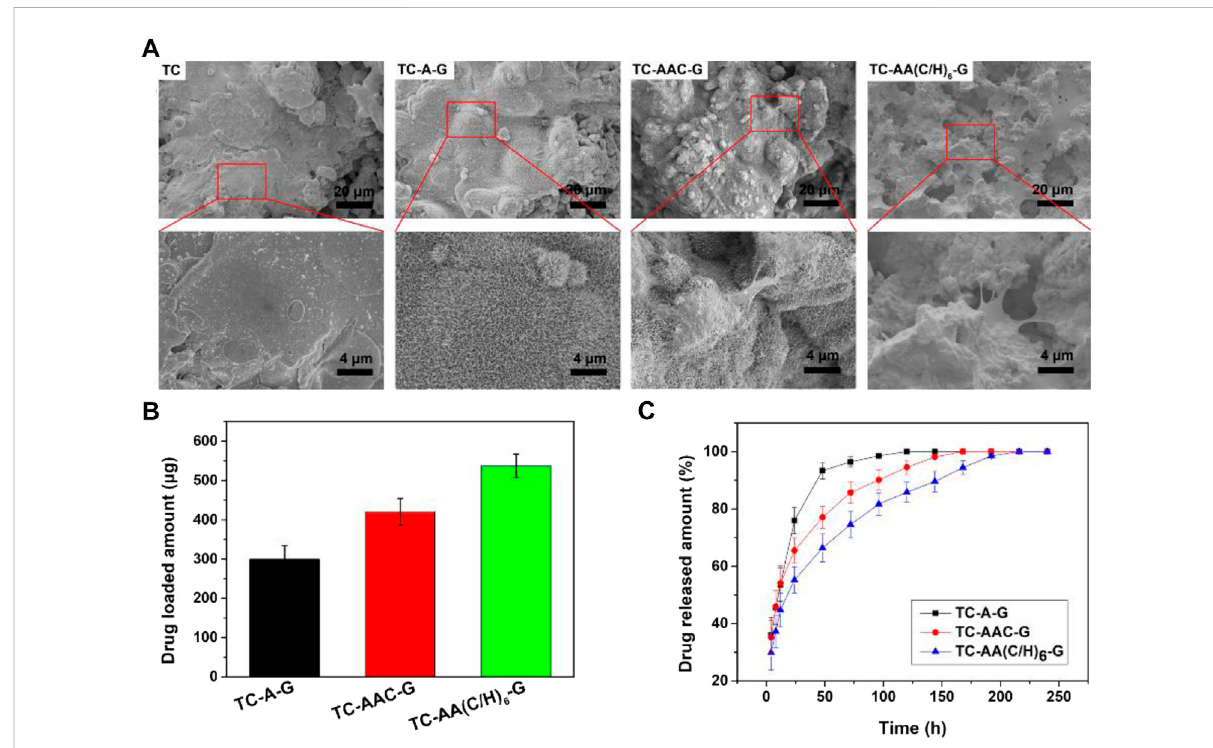
FIGURE 2 SEM of samples (A) , Drug loaded amount (B) and cumulative release curves of gentamicin (C) of TC-A-G, TC-AAC-G and TC-AA(C/H) 6